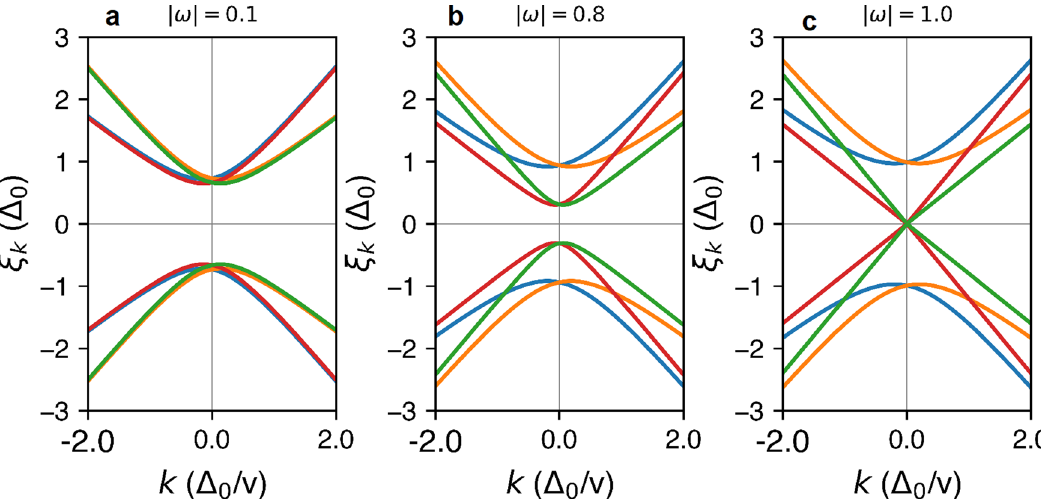
Fig. 4 Degeneracies in the Bogoliubov-de Gennes quasiparticles. Bogoliubov-de Gennes (BdG) quasiparticle bands near the Dirac point for three values of the j ω ! j ¼ a 0.1, b 0.8, and c 1.0 resulting in gapped, weakly nonunitary, and gapless fully nonunitary states, respectively. Energy units correspond to Δ o = 0.7 meV, v = 500 and β = 100, see Eq.